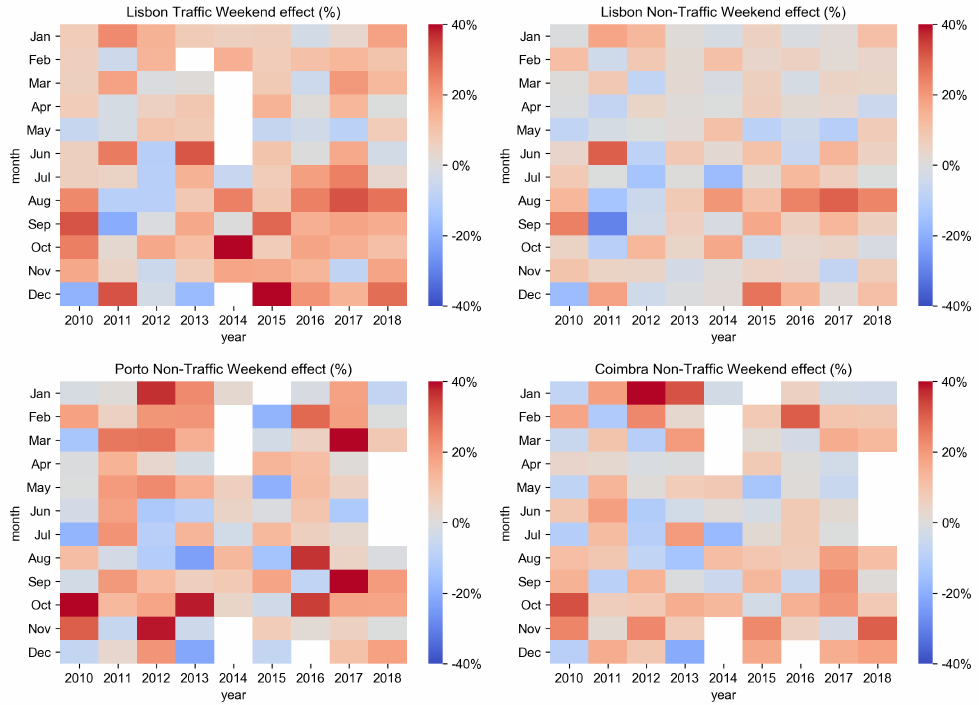
Figure 16. O 3 Seasonality of WD versus WE by percentage using the proposed equation 8. See colored version in Journal website for ease of interpretation. Weekend effect (%) by month and year for Lisbon Traffic ( top-left ), Lisbon Non-Traffic ( top-right ), Porto Non-traffic ( bottom-left ), and Coimbra Non-Traffic ( bottom-right ).